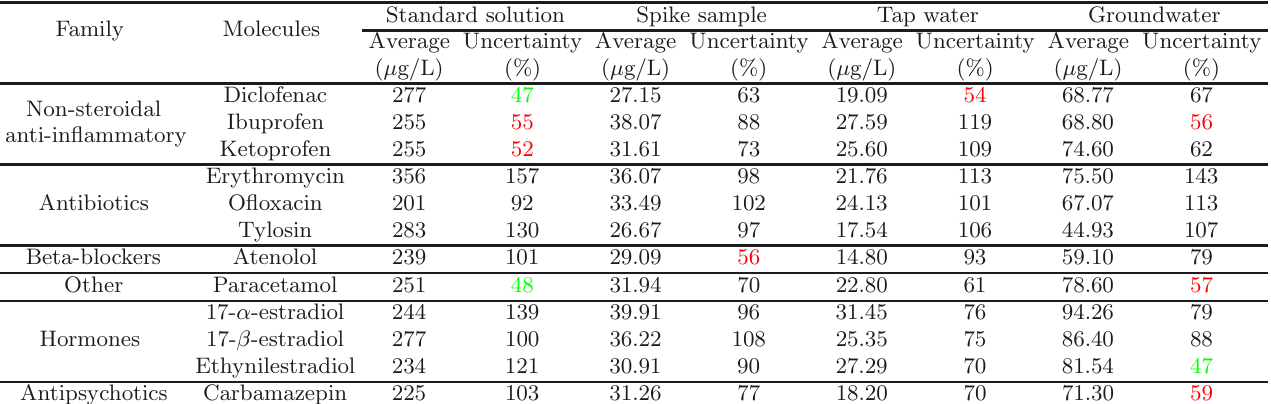
Table 2. Mean concentration and uncertainty by compound and by